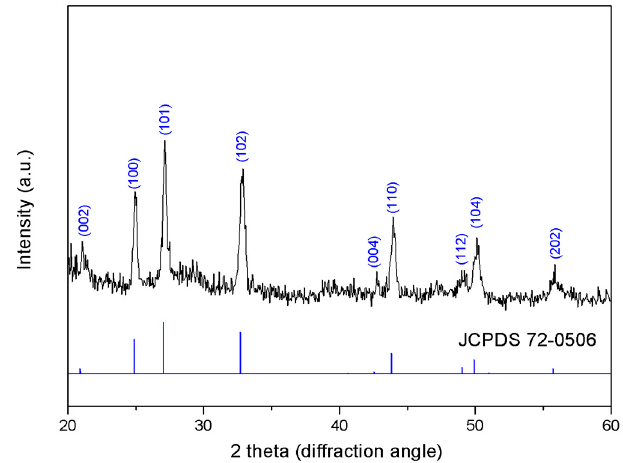
Figure 2. X-ray powder diffraction pattern of CaCO 3 :Ce by Cu K α radiation ( λ = 1.5406 Å) in 2 θ ranging from 20° to 60°.